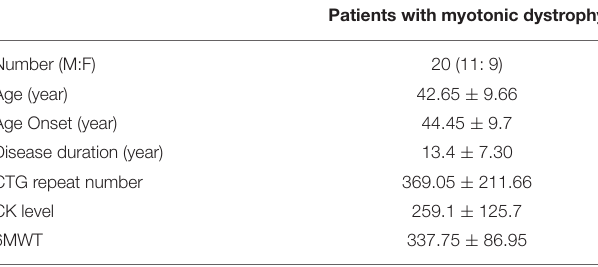
TABLE 1 | Baseline characteristics of DM1 patients. TABLE 2 | The spatio-temporal gait parameters from GAITRite difference between DM1 and